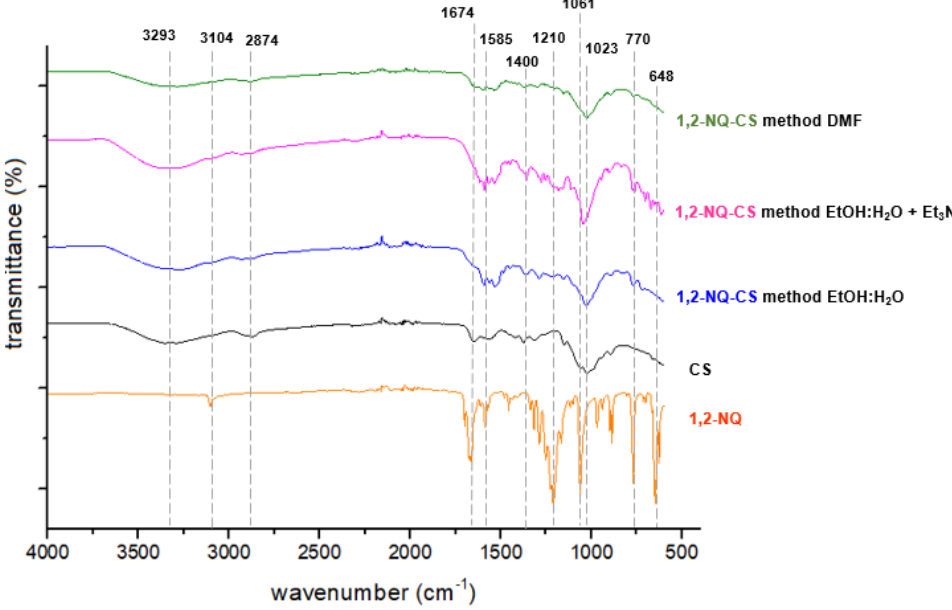
Figure 3. FTIR spectra of 2,3-dichloro-1,4-naphthoquinone (1,4-NQ), chitosan (CS), 1,4-NQ-CS obtained by the EtOH:H 2 O method, 1,4-NQ-CS following the EtOH:H 2 O + Et 3 N region and 1,4-NQ-CS following the DMF method.